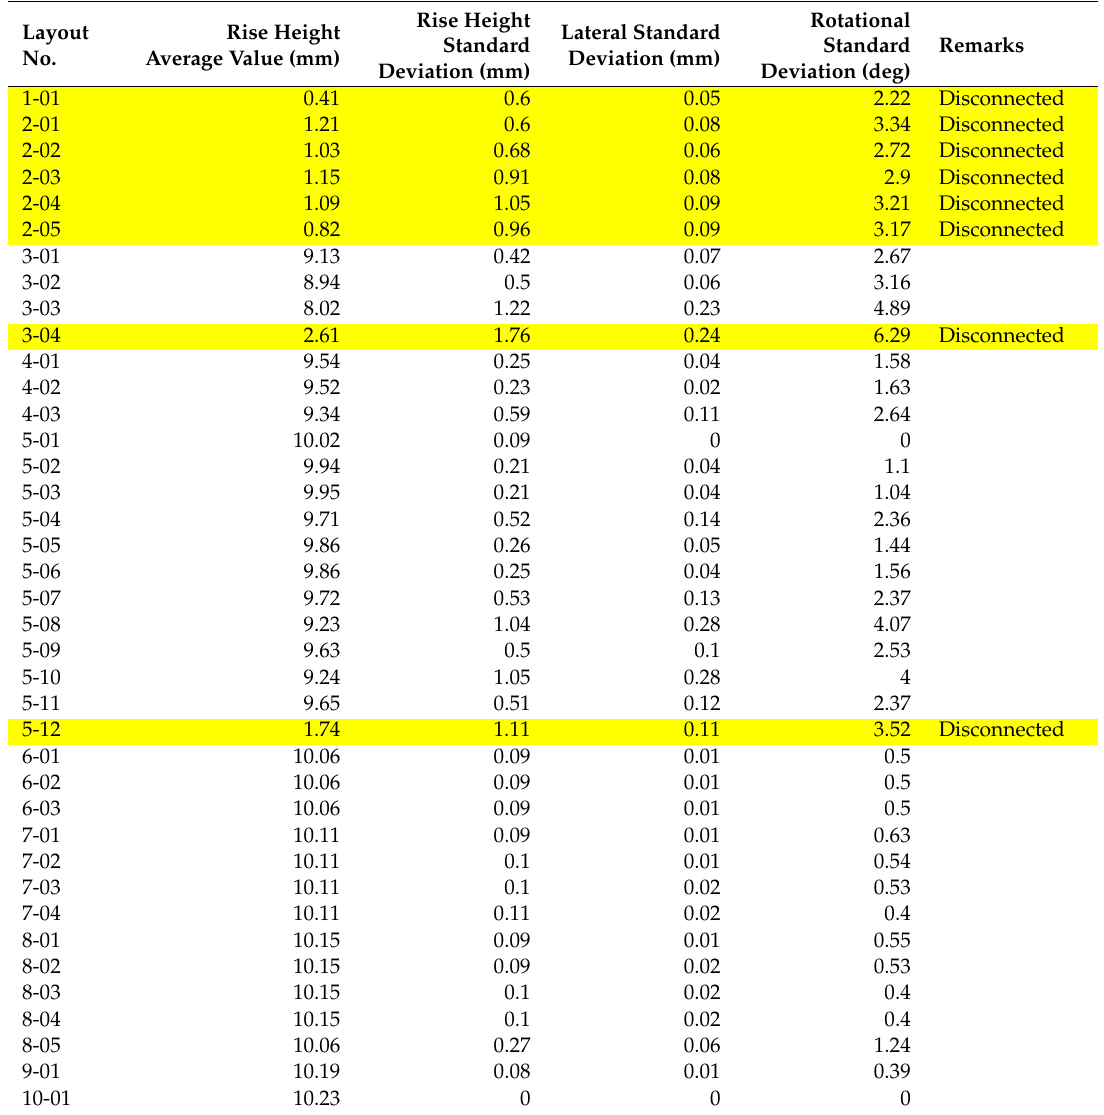
Table 1. Simulation results of 10 connected microrobots’ movements surrounding a pipe. Layout No. indicates the same numbers shown in Figure 12. In the yellow background case, the robot is disconnected, and the pipe cannot be